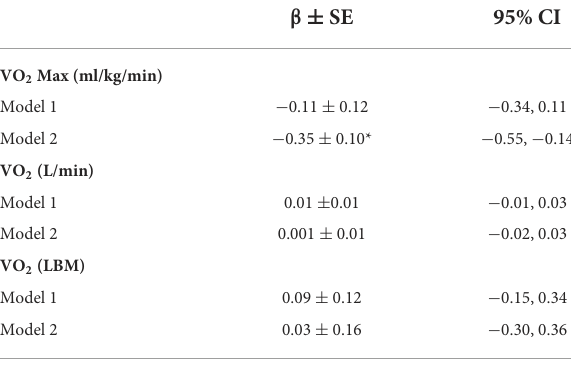
TABLE 5 Multiple regression analysis models exploring the association of EDII with